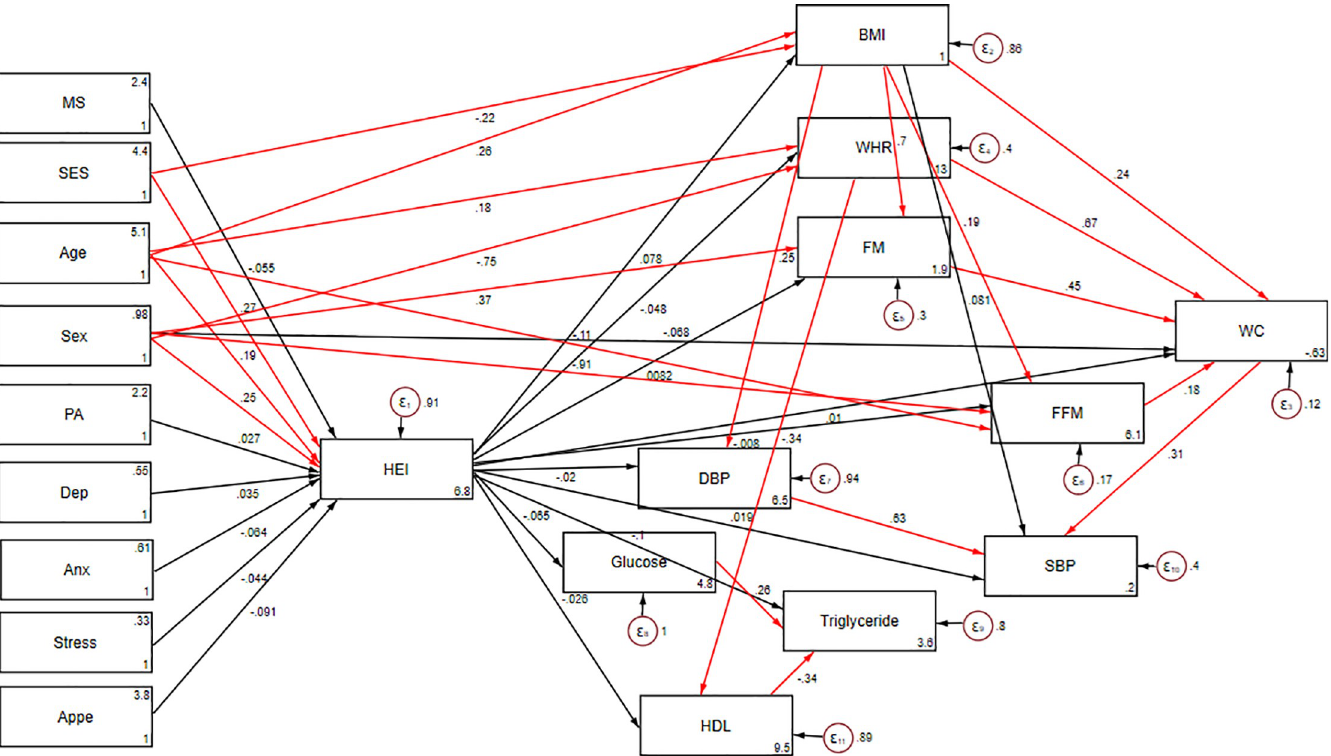
Fig 5. Path analysis diagram with standardized estimates illustrating the total effects of socio-demographic and psychological parameters and diet on cardio- metabolic risk factors. Abbreviations: HEI, healthy eating index; WHR, waist–hip ratio; BMI, body mass index; WC, waist circumference; FM, fat mass; FFM, fat free mass; SES, socio-economic status; SBP, systolic blood pressure; DBP, diastolic blood pressure; HDL, high-density lipoprotein; PA, Physical activity; MS, marital status; Anx, anxiety; Dep, depression; Appe, appetite. � All path coefficients are standardized. Red arrows mean p.value � 0.05. £ Total effect is defined as the sum of direct and indirect